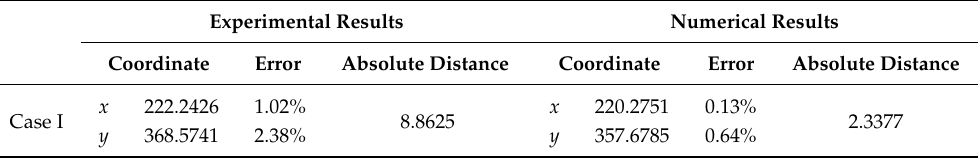
Table 4. Comparison of experiment and simulation results under Case